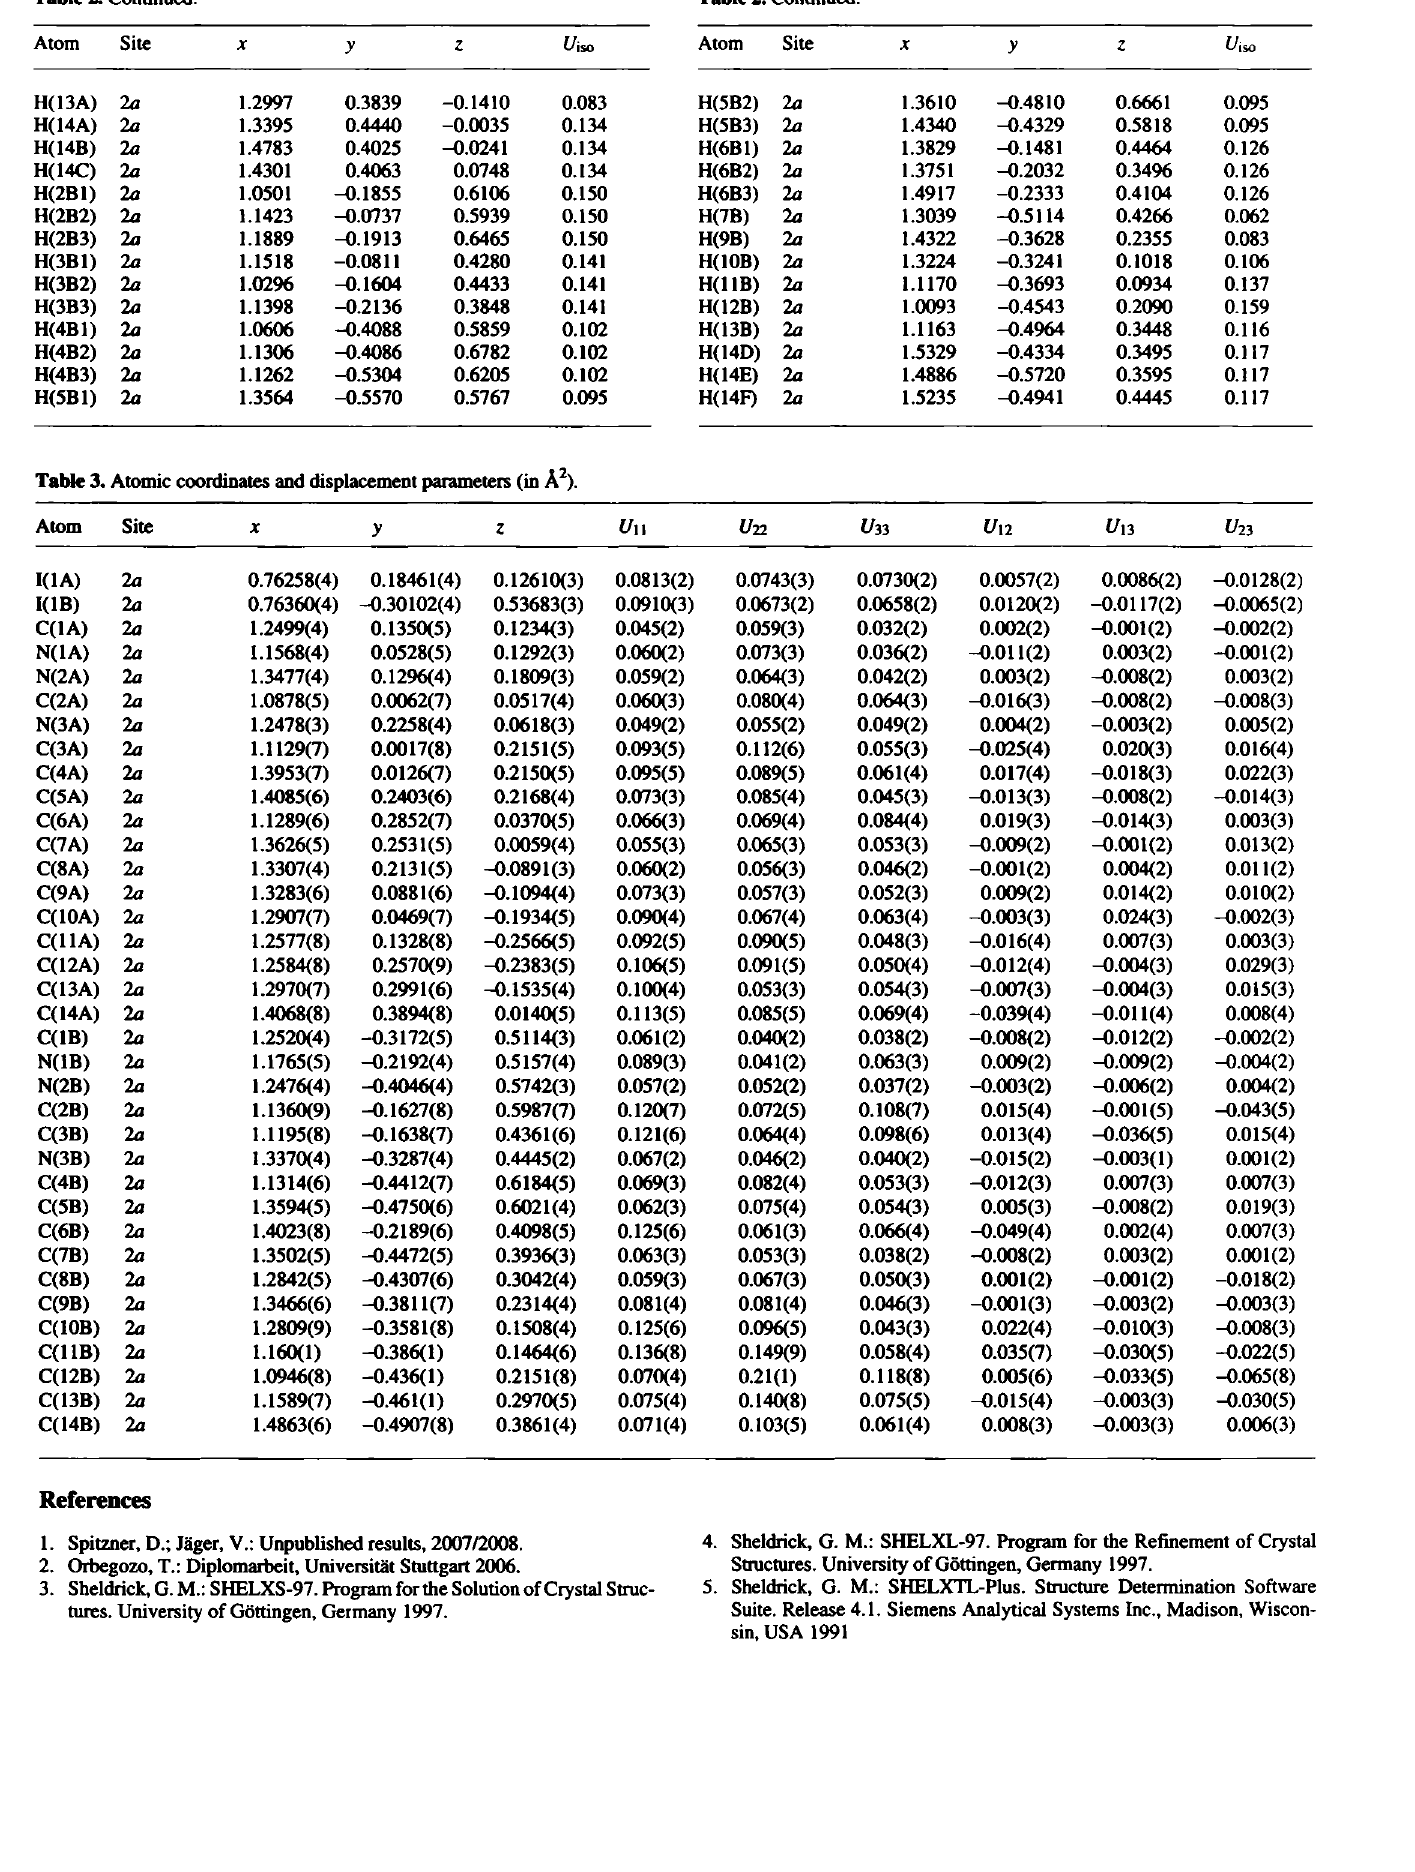
Table 3. Atomic coordinates and displacement parameters (in Â 2